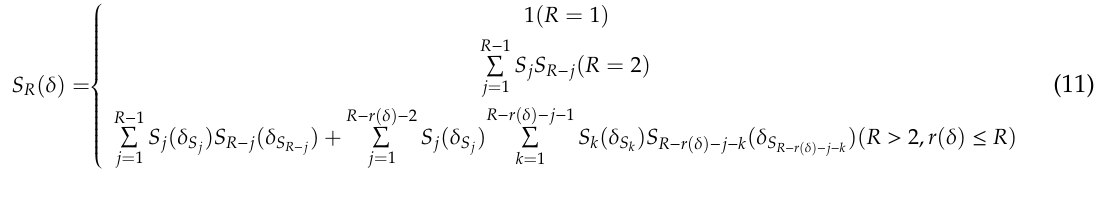
Figure 8. Part of the possible sequences of the four-component alkane case and their TAC